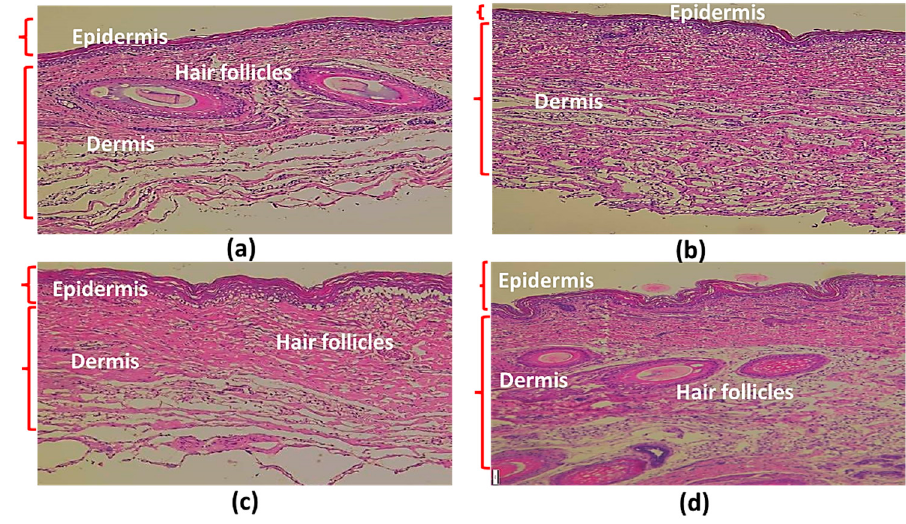
Figure 4. Sections of porcine skin. Untreated skin ( a ), skin treated with PWCCS0.15 ( b ), skin treated with S3 ( c ) and with S4 ( d ).